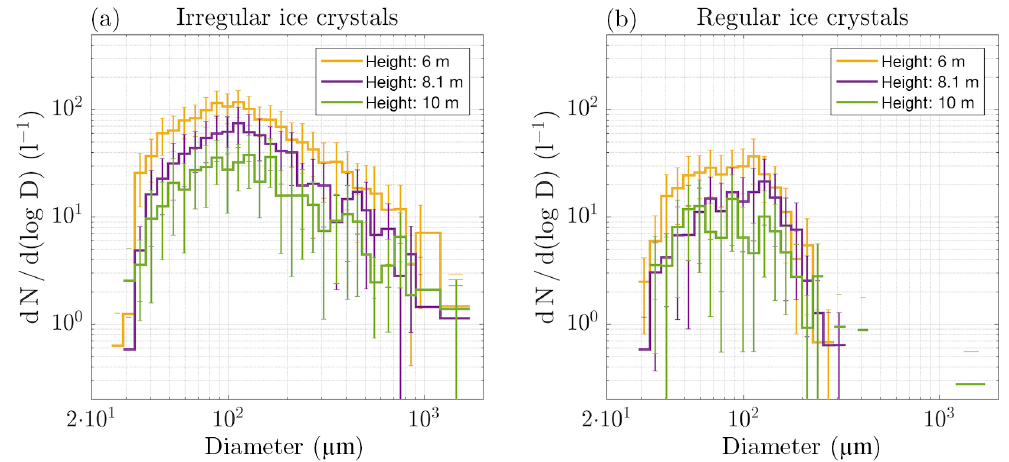
Figure 14. Number size distribution of the irregular (a) and regular (b) ice crystals observed on 17 February 2017 as a function of height. The error bars represent the standard error of the mean. Aggregates are not shown because of their low concentrations.